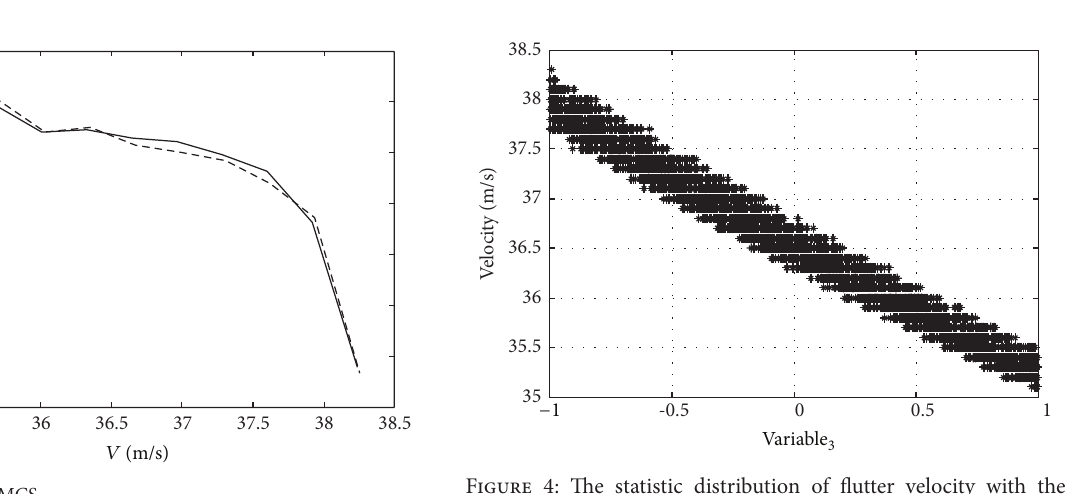
Figure 4: The statistic distribution of flutter velocity with the uncertainty of 3rd aerodynamic pressure